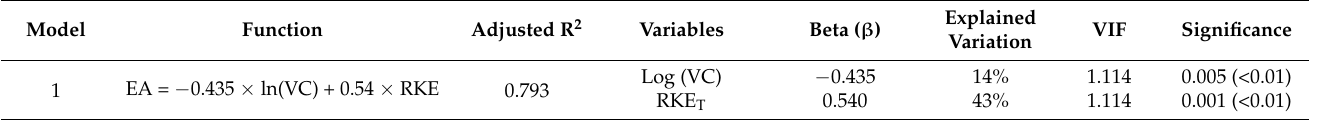
Table 3. Multiple regression analysis of erosion amount, VC, and